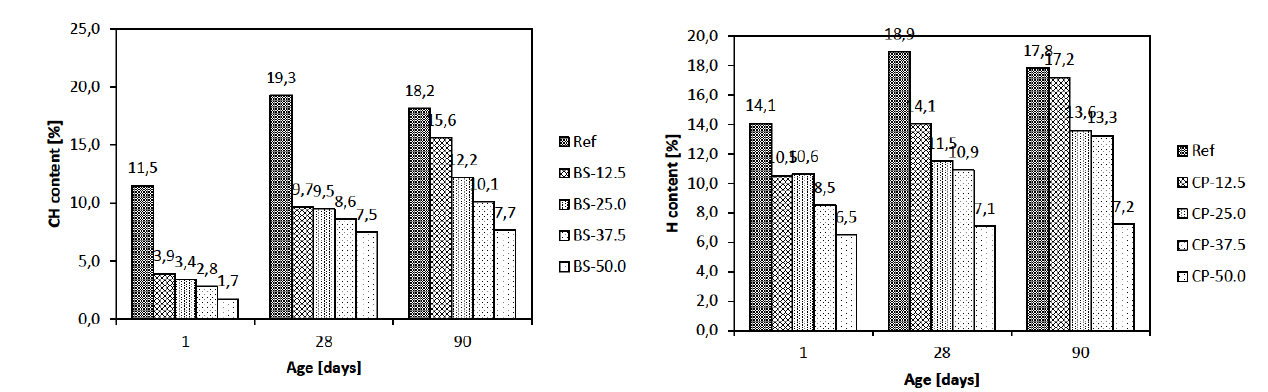
Figure 8: Development of Ca(OH) 2 in pastes with ceramic powder addition in time.